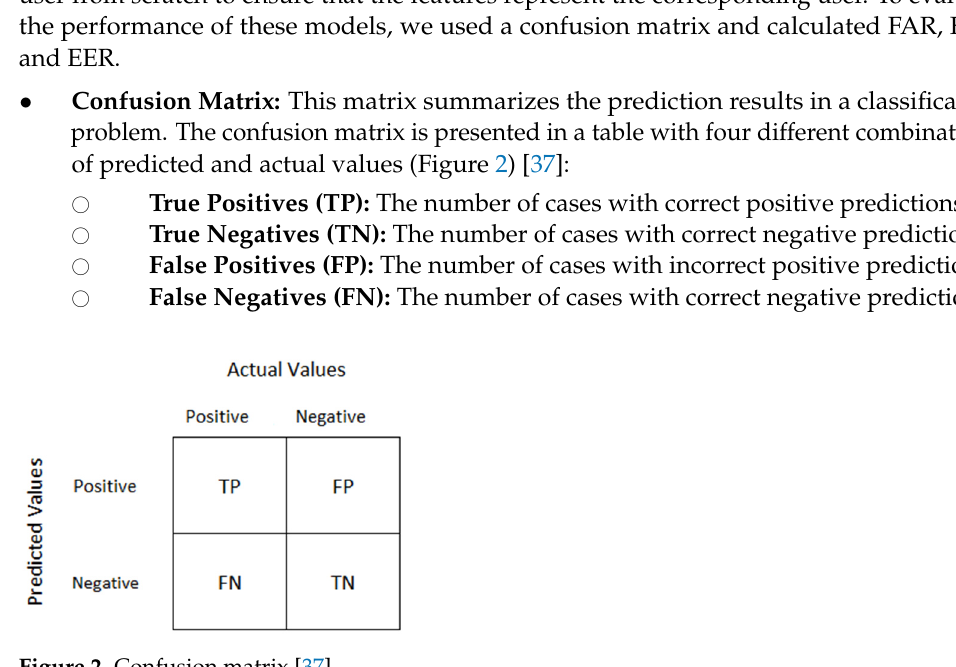
Figure 2. Confusion matrix [37].